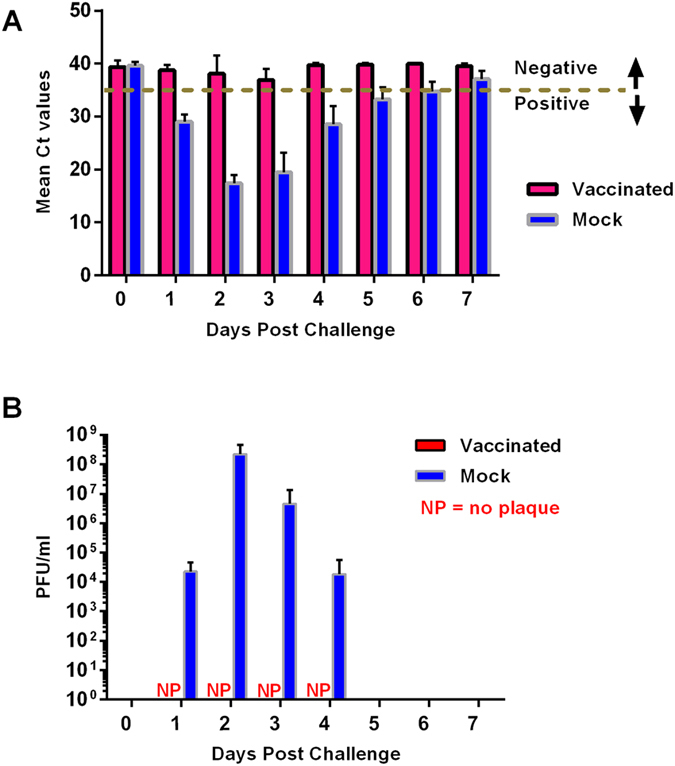
Viremia in vaccinated and mock-vaccinated sheep following virulent RVFV challenge.(A) Shows mean QRTPCR Ct values for vaccinated and mock-vaccinated groups. (B) Shows quantitation of viremia by plaque assay. Dash line (---) denotes cut-off point. NP = no plaque was isolated. Blanks on the graph (from 5 to 7 dpc) depict no virus was isolated from sheep in either group, vaccinated or mock-vaccinated, by plaque assay.